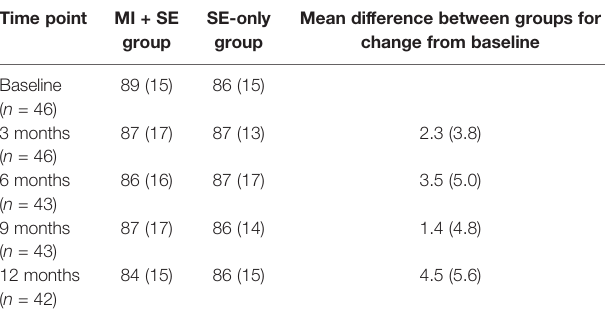
TABLE 2 | HbA1c levels at baseline and three, six, nine, and 12 months (all fi gures are means +/- SD), showing no signi fi cant differences between groups at any point ( P = 0.43 – 0.77), although the MI+SE group ’ s fi gure seemed to be lower than the baseline at all measurement